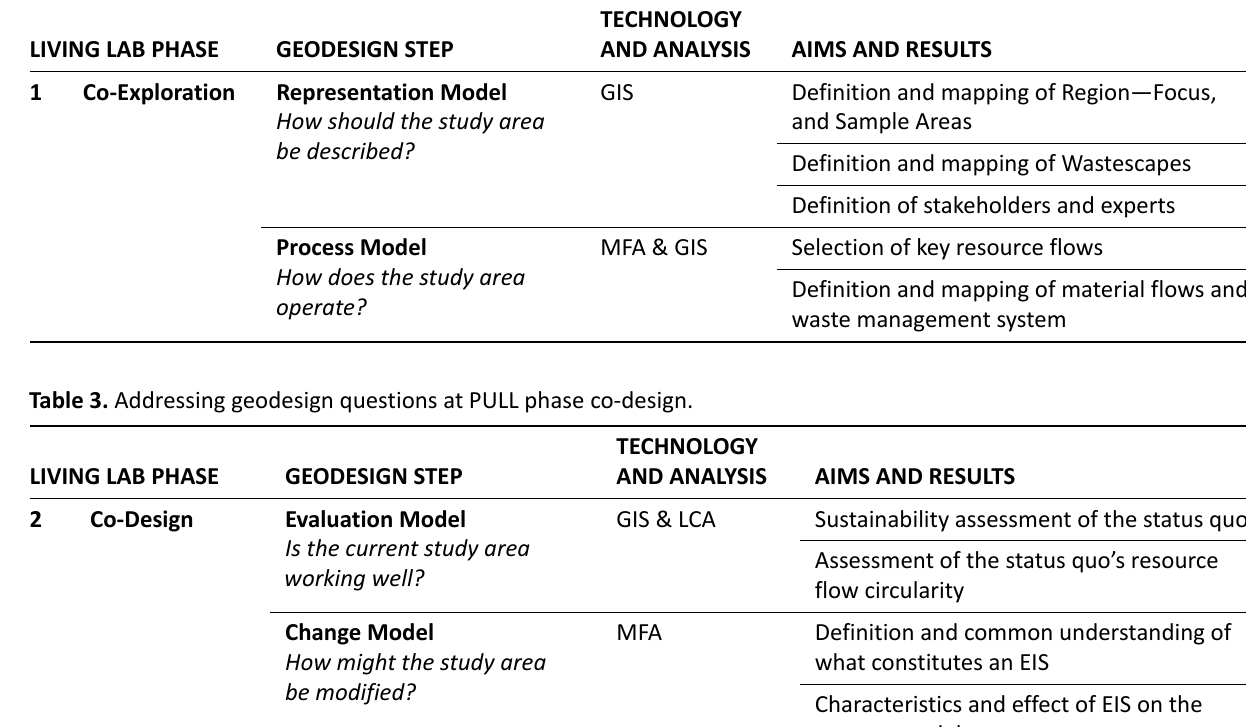
Table 2. Addressing geodesign questions at PULL phase co-exploration.